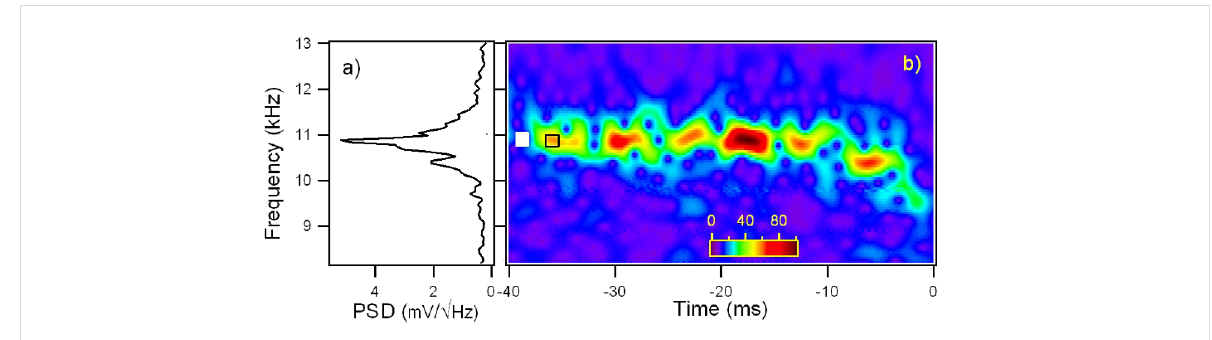
Figure 6: a) Power spectral density of the Brownian motion of the first flexural mode of the same temporal trace used for the wavelet transform on the right. b) Wavelet transform of the Brownian motion of the cantilever first flexural resonance, around its instantaneous equilibrium position, as the tip approaches the surface at constant velocity (9 nm / 40 ms = 225 nm/s). The wavelet coefficients | Wf ( f,t )| are coded in colorscale. The origin of the time axis corresponds to the instant when the jump-to-contact occurs. The white box at the left side represents the Heisenberg box, the open box delimited by black lines represents the damped oscillator in response to an impulsive thermal